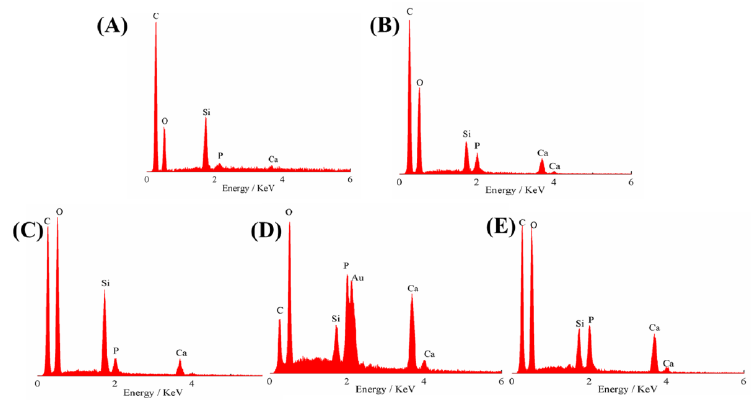
Figure 3. Surface microstructures and morphologies of the nHA-PBP hybrid membranes. ( A ) 0 wt% nHA, ( B ) 20 wt% nHA, ( C ) 30 wt% nHA, ( D ) 40 wt% nHA, ( E ) 50 wt% nHA.